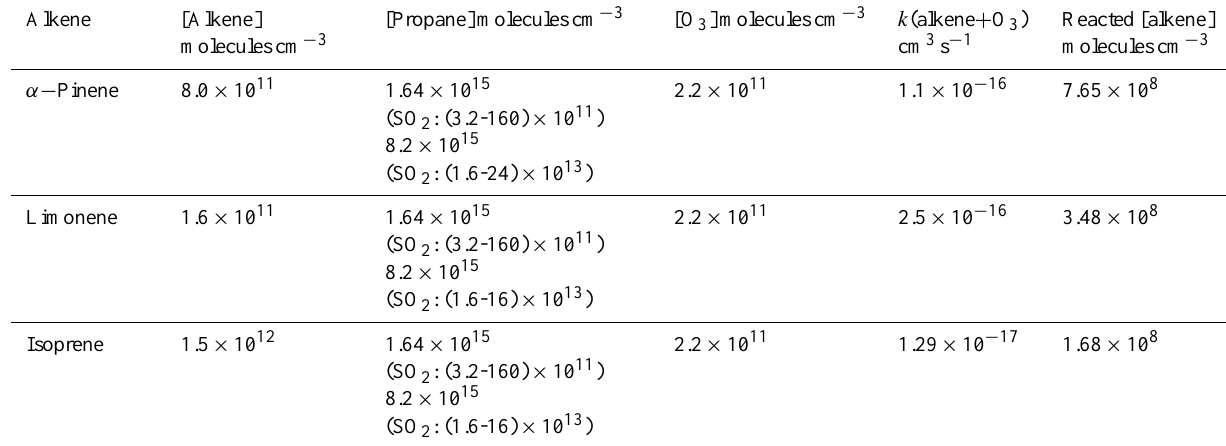
Table 1. Concentrations of alkenes (initial and reacted within the residence time of 39.5s), OH scavenger and O 3 , and the reaction rate coefficients used in the